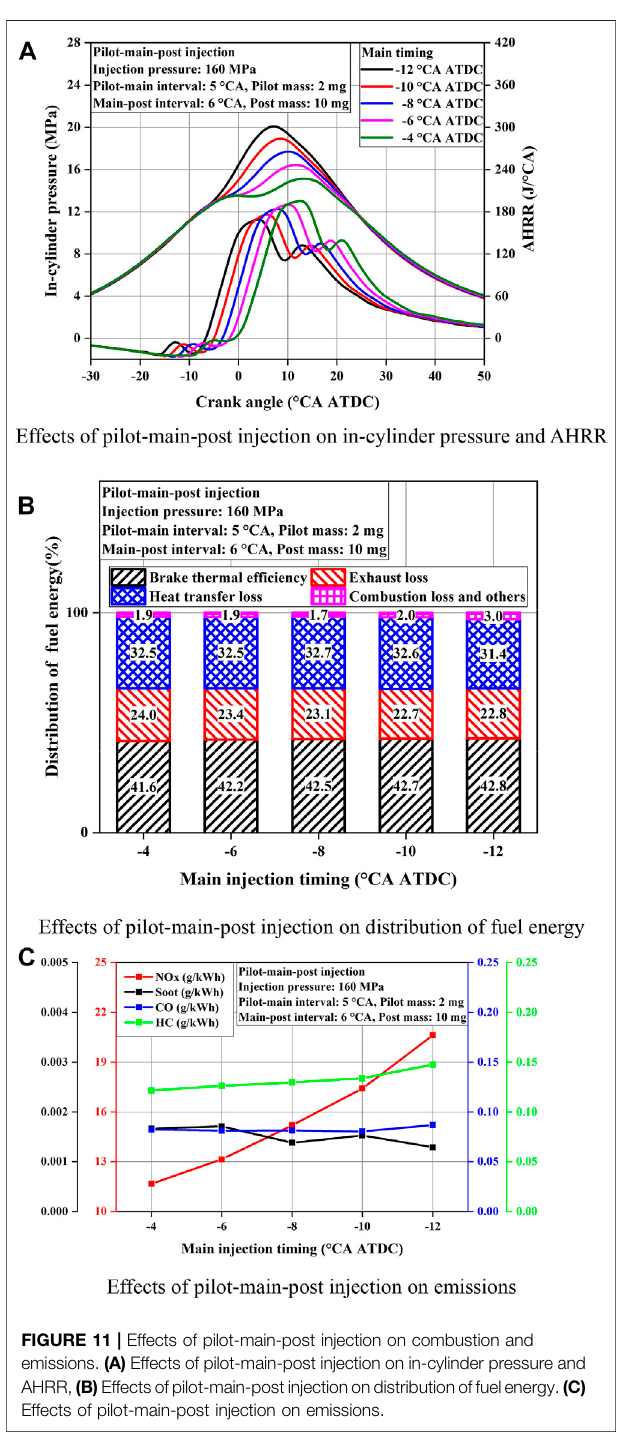
Frontiers in Energy Research |